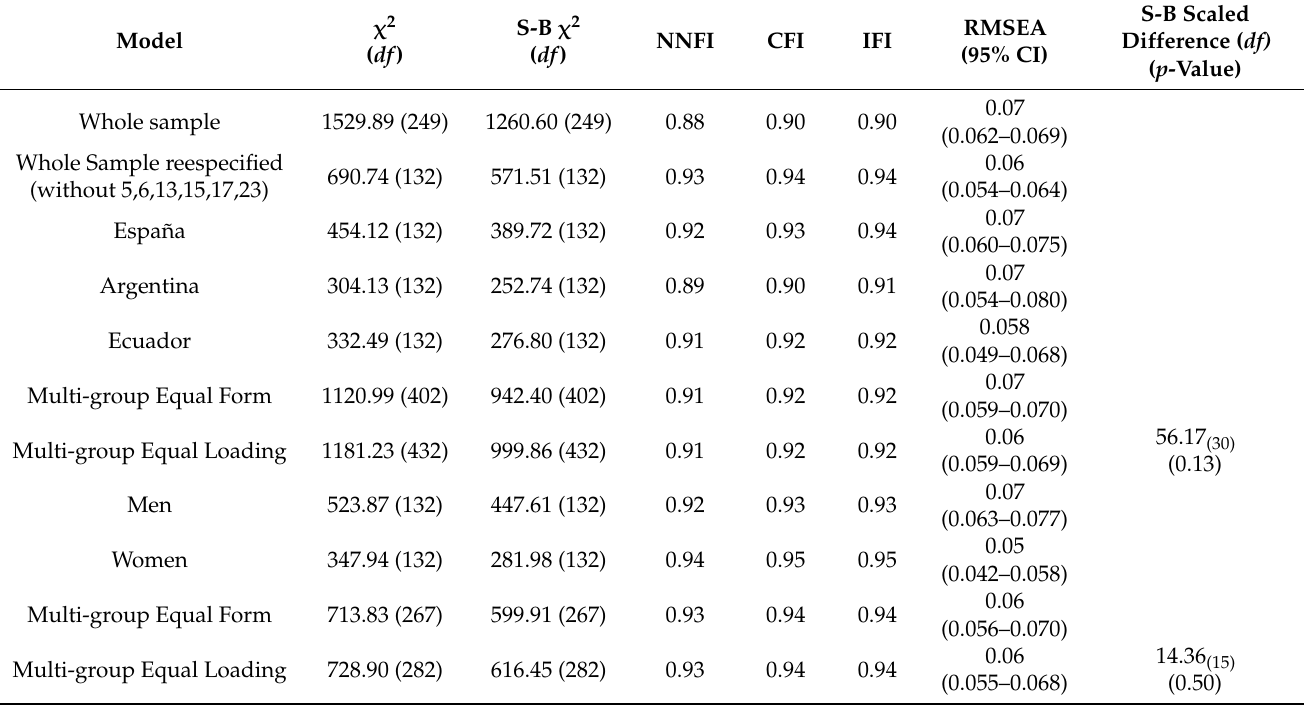
Table 2. Goodness-of-fit index of the TMMS-24 scale in the three countries.